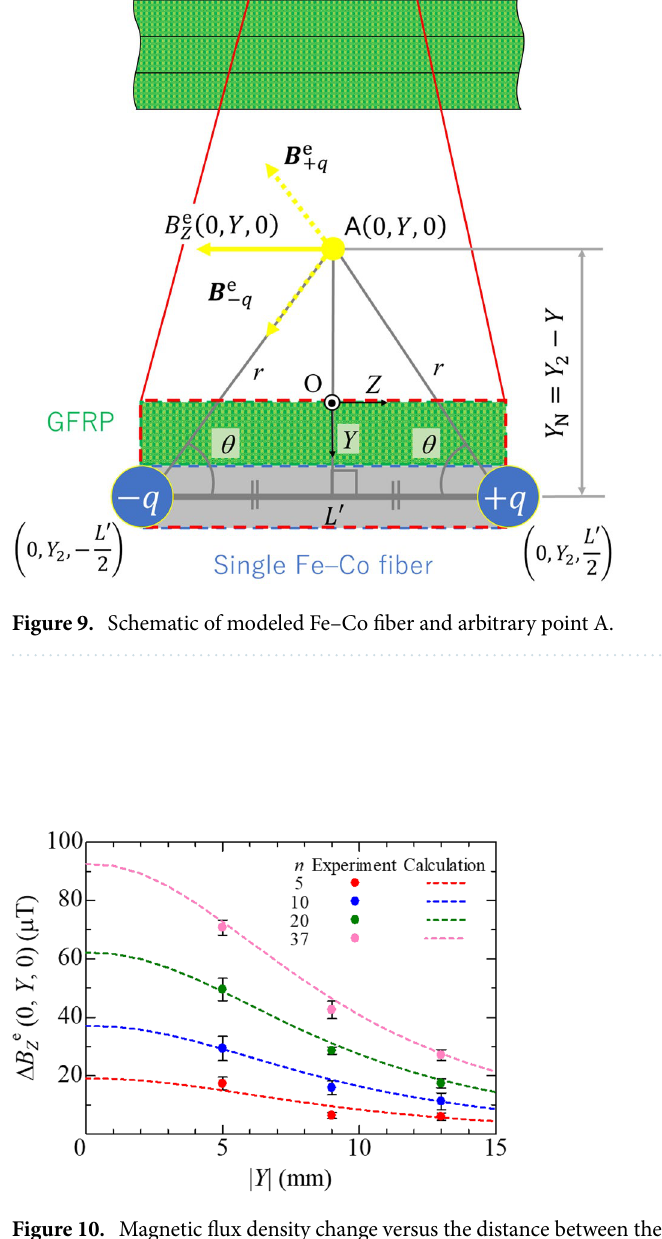
Figure 10. Magnetic flux density change versus the distance between the specimen surface and the Hall probe’s